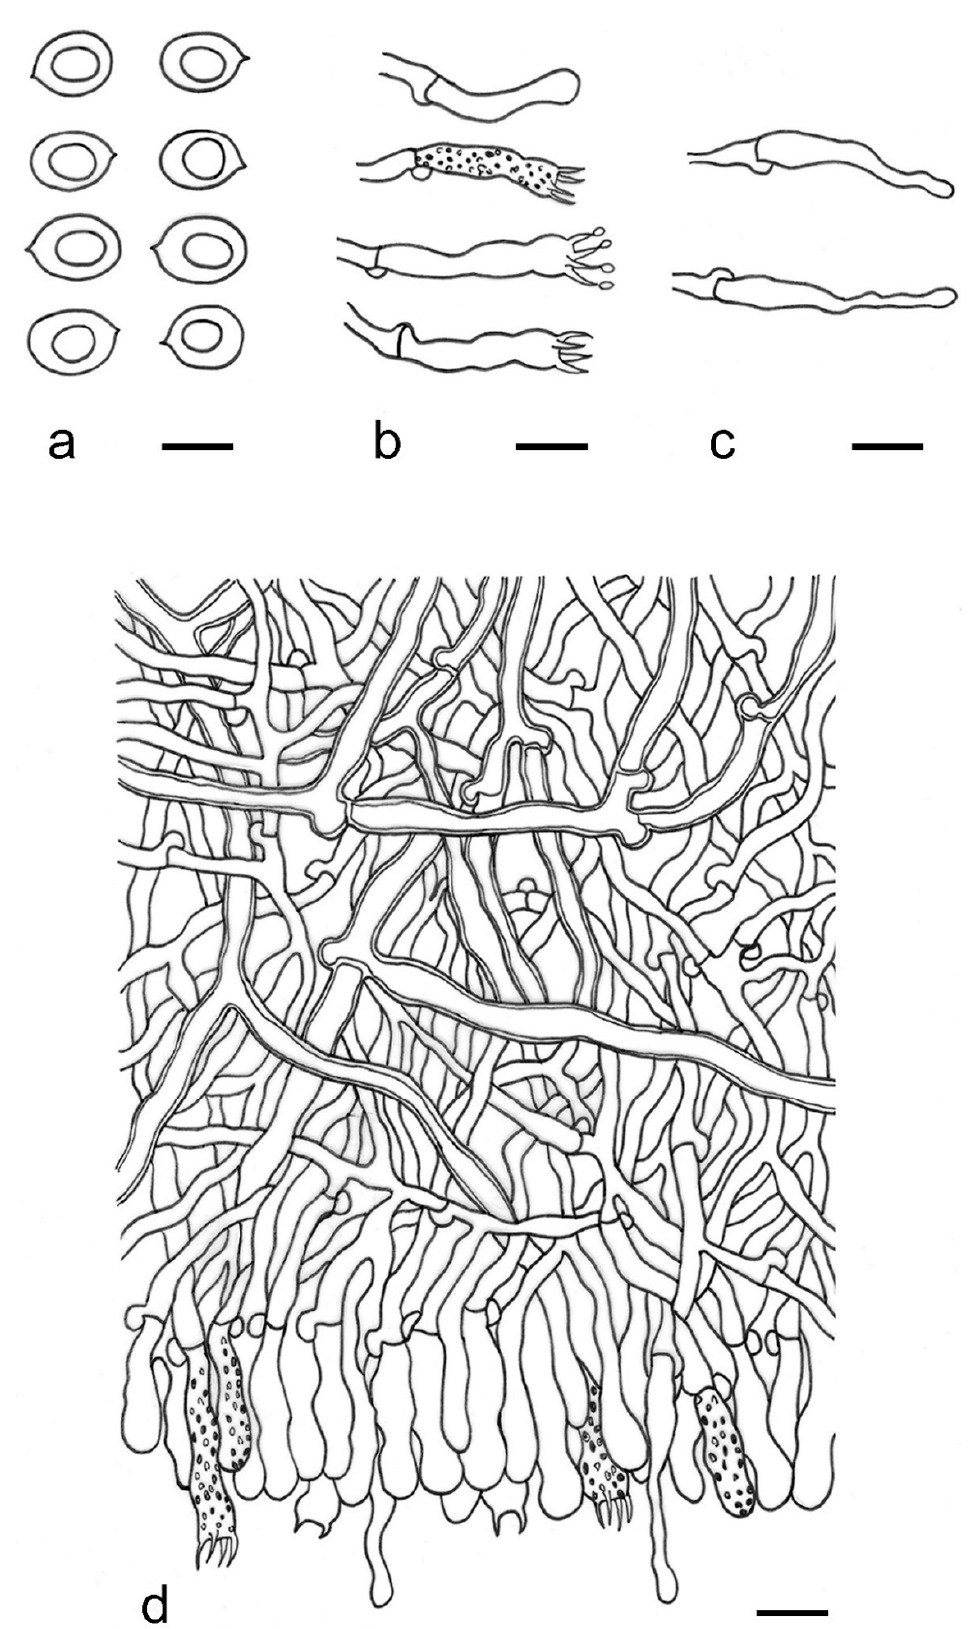
Figure 23. Microscopic structures of Xylodon australis (drawn from the epitype). ( a ) Basidiospores; ( b ) basidia and basidioles; ( c ) subulate cystidia; ( d ) a section of the basidiocarp.—Scale bars: a = 5 μ m; b–d = 10 μ m.